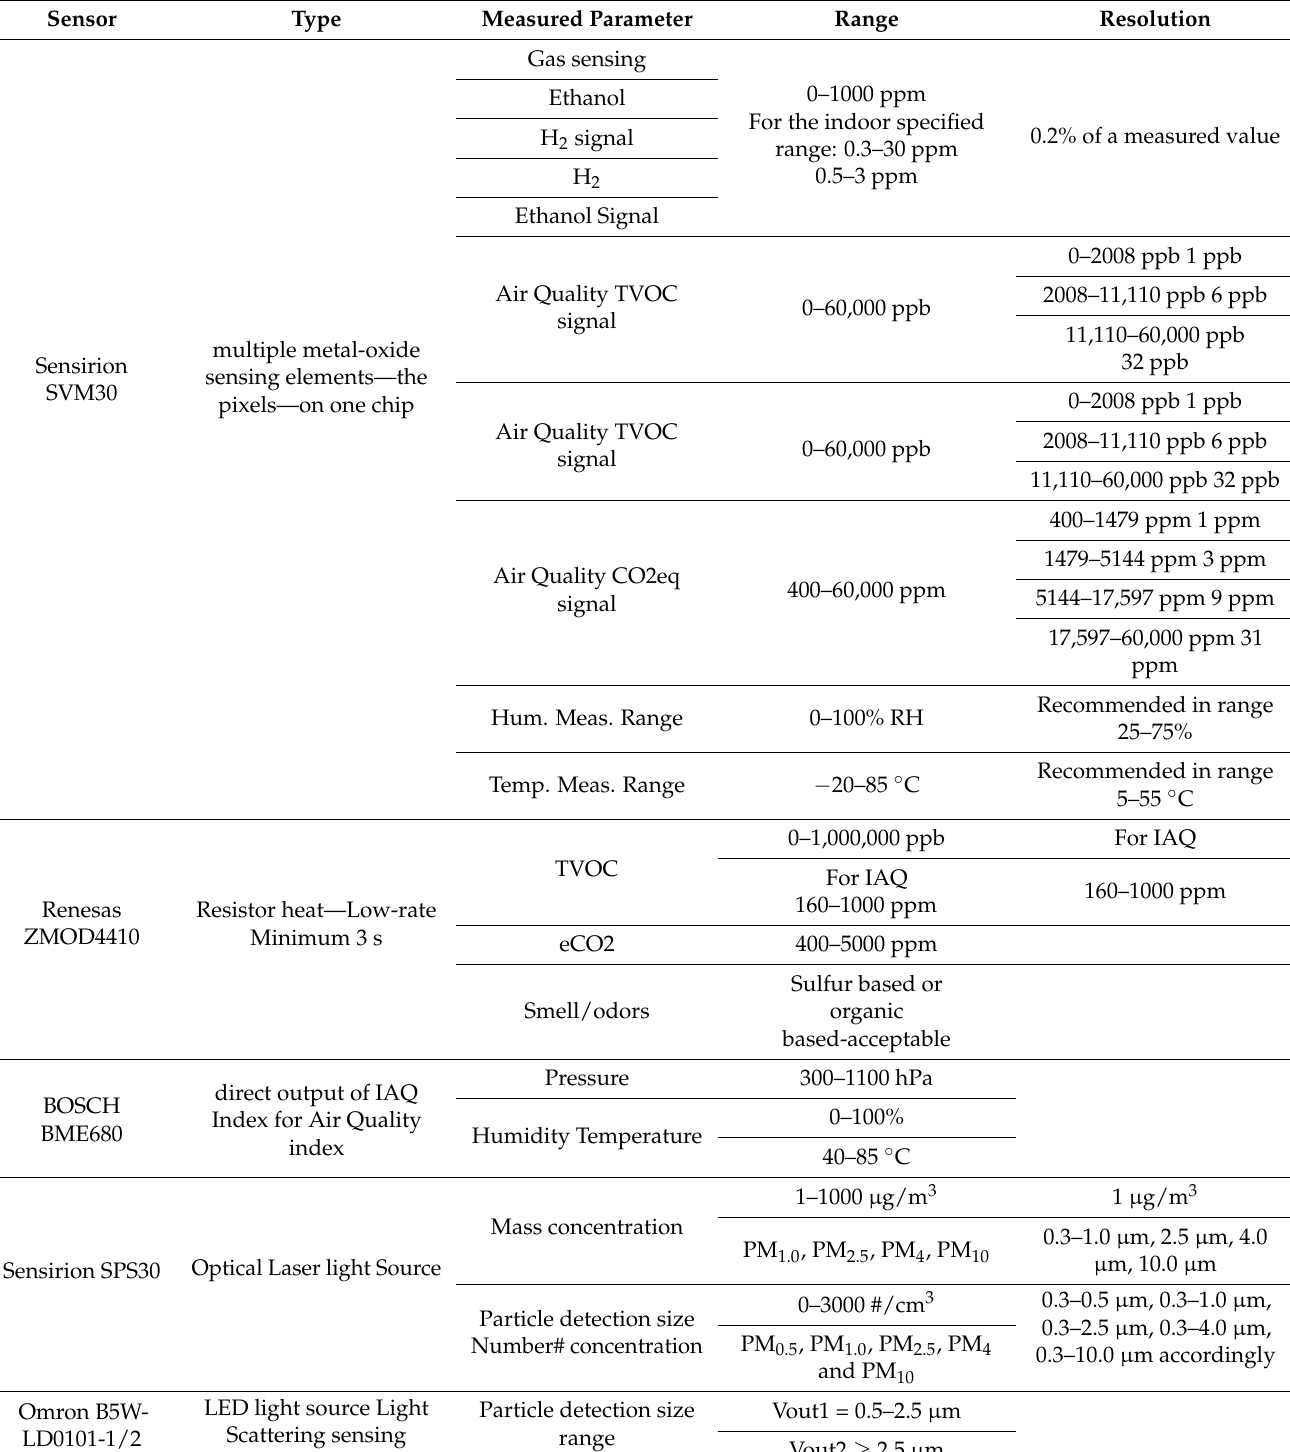
Table 2. Sensor characteristics and performance. Unit ppm is an abbreviation for “parts per million” describing dilute solutions in chemistry also expressed as milligrams per liter (mg/L). Accordingly, ppb stands for “parts per billion” that corresponds to 1 µ